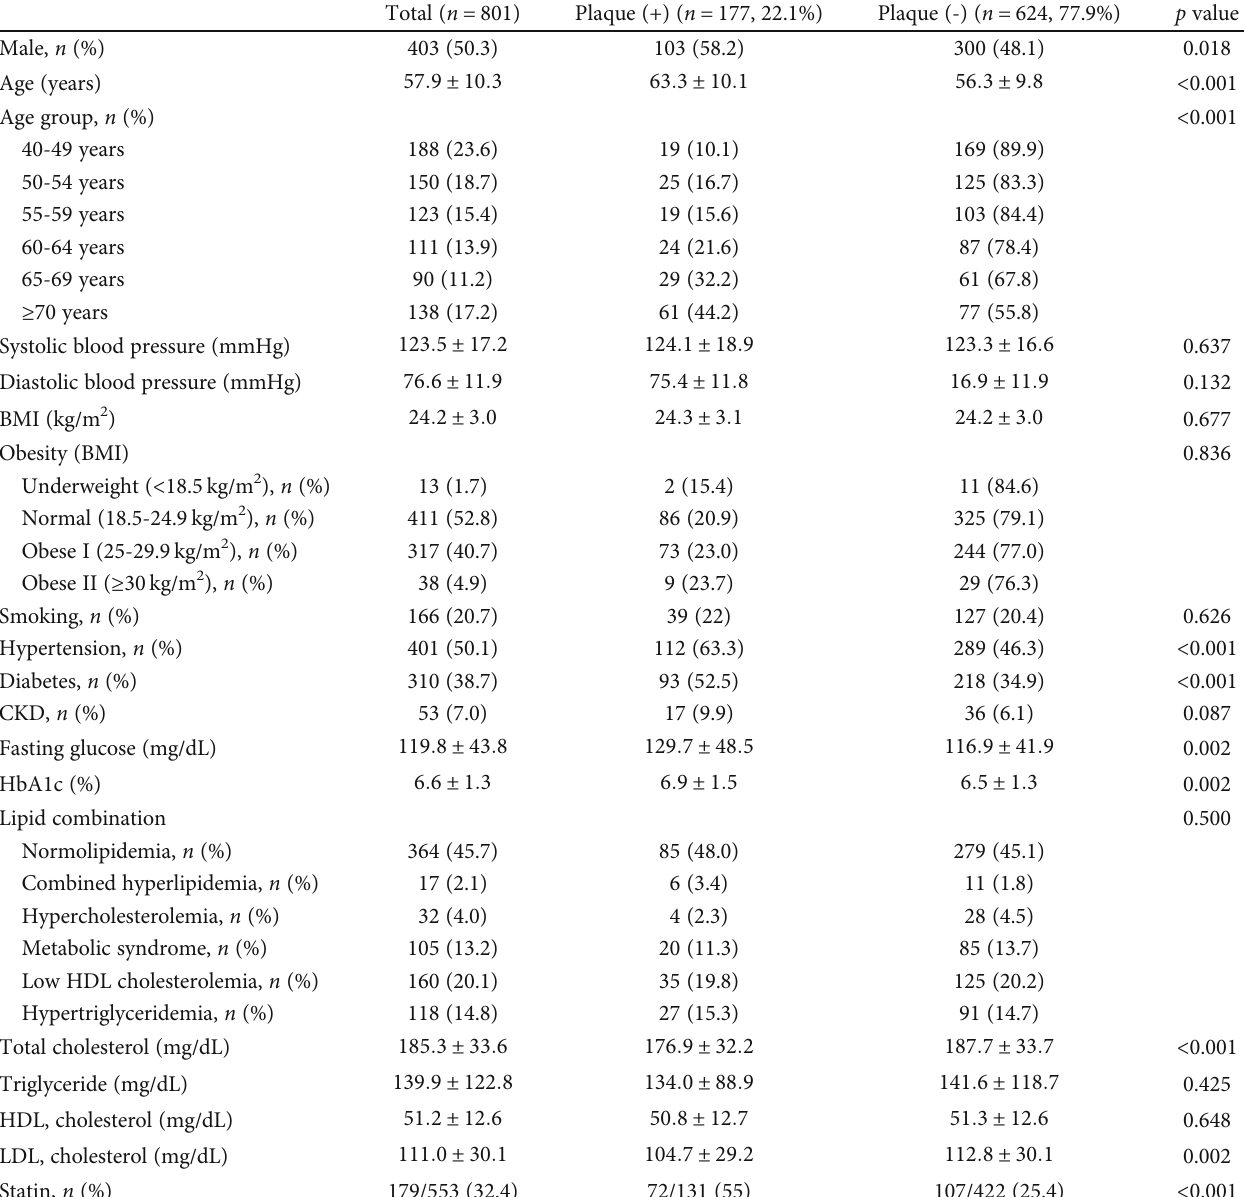
Table 1: Demographics of the subjects according to the presence of plaque. Total ( n = 801 ) Plaque (+) ( n = 177 ,